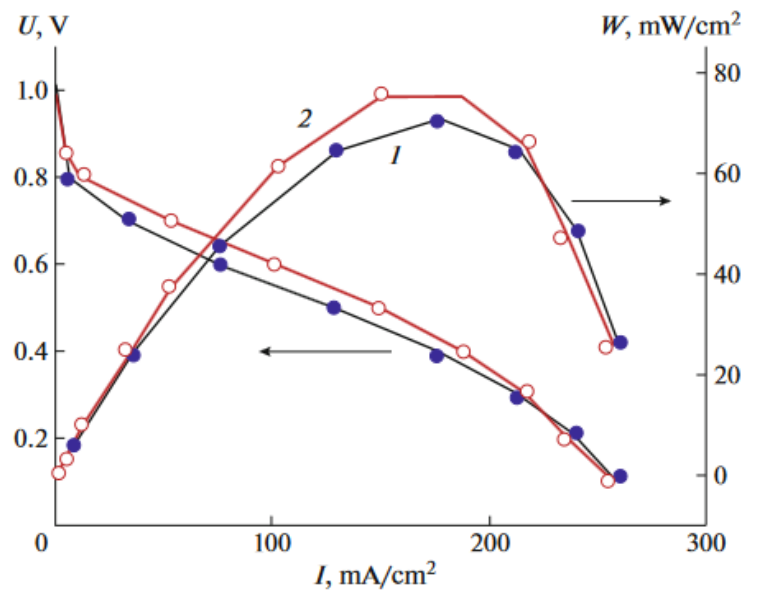
Figure 14. Current–voltage characteristics of the membrane electrode block with a membrane based on sulfonated PPQs with the sulfur contents of 8.0 (1) and 6.0% (2) with thicknesses of 25 and 20 µ m, respectively, and relative humidity of 75 (1) and 95% (2) (figure reprinted with permission Pleiades Publishing, Ltd. from Ref. [27]).